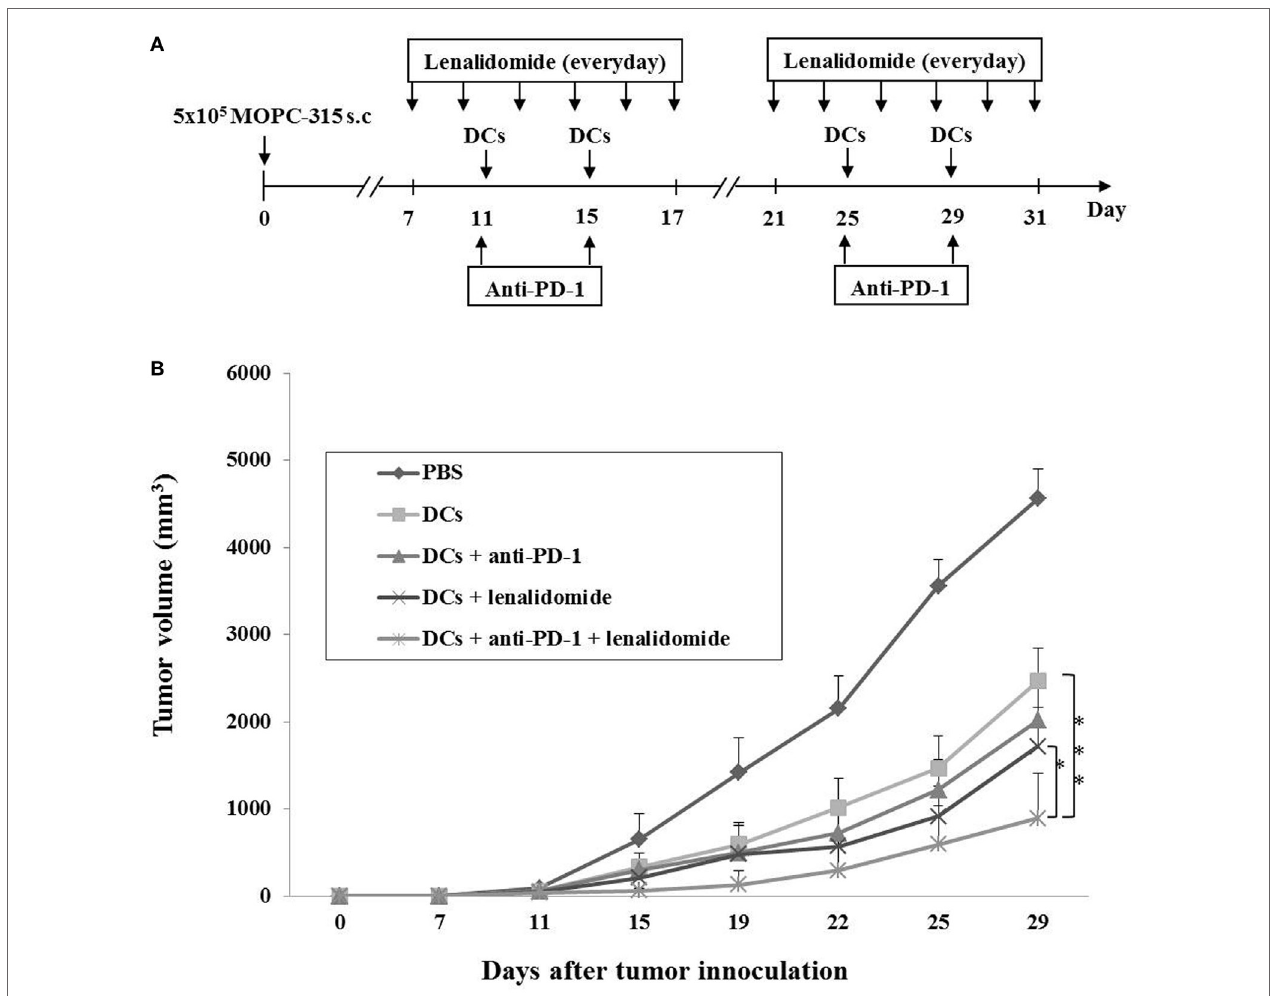
FigUre 1 | In vivo animal vaccination Five vaccination groups were established: (1) PBS control, (2) dying myeloma cell-loaded dendritic cell (DC) vaccination, (3) DC vaccination plus anti-PD-1, (4) DC vaccination plus lenalidomide, and (5) DC vaccination plus lenalidomide and anti-PD-1. On day 0, MOPC-315 cells (5 × 10 5 / mouse) were injected subcutaneously into the right flank of BALB/c mice. (a) Schematic representation of the combination of DCs plus lenalidomide and anti-PD-1. After tumor growth, lenalidomide (0.5 mg/kg/day) was administrated orally once a day for 25 days with a 3-day break after the first 11-day dosing period. Each dose of DCs (1 × 10 6 /mouse) was injected subcutaneously into the left flank of BALB/c mice in a volume of 0.1 mL PBS on days 11, 15, 25, and 29. Anti-PD-1 (250 μ g/ mouse) was injected intraperitoneally on the same days as DC vaccination. (B) Data are presented as mean ± SEM and are representative of two independent experiments. The combination of DCs plus lenalidomide and anti-PD-1 significantly inhibited tumor growth (* P < 0.05; *** P < 0.001 on day 29) and induced a long-term systemic anti-myeloma immune response (29